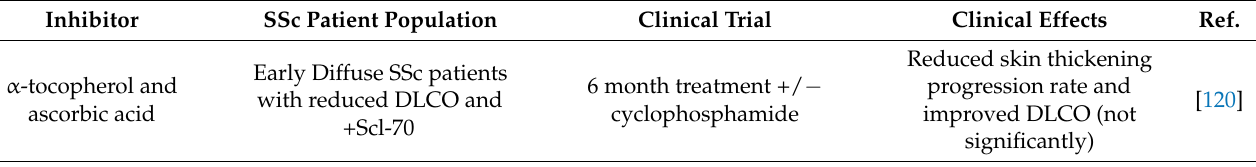
Clinical Effects